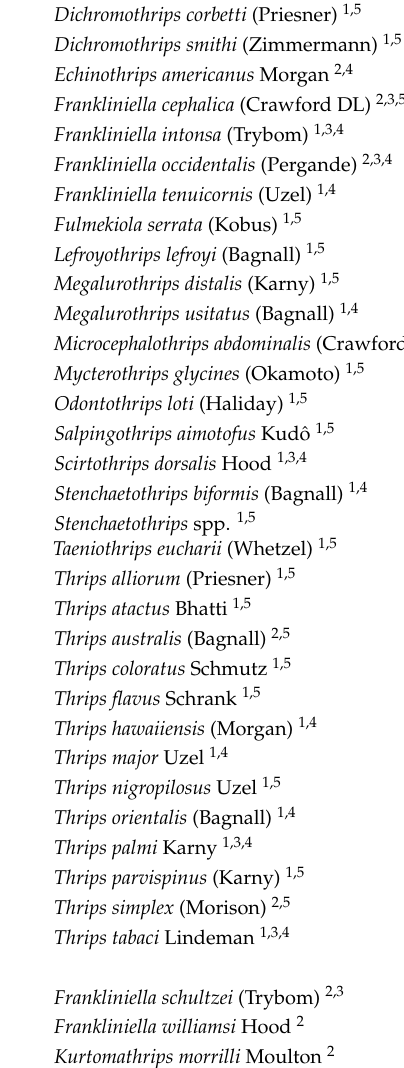
Table 3. ( A ) Pest Thripidae species in China (by subfamily). ( B ) Pest Thripidae of little economic importance in